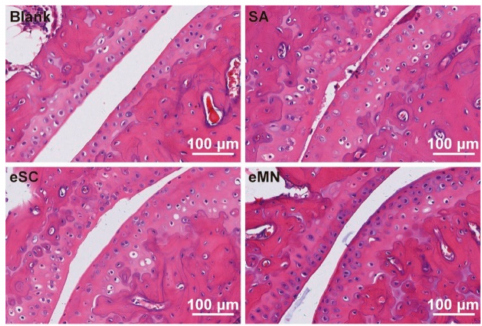
Figure 6. Representative H&E stained images of ankle joints from normal mice and AIA mice treated with SA, eSC, and